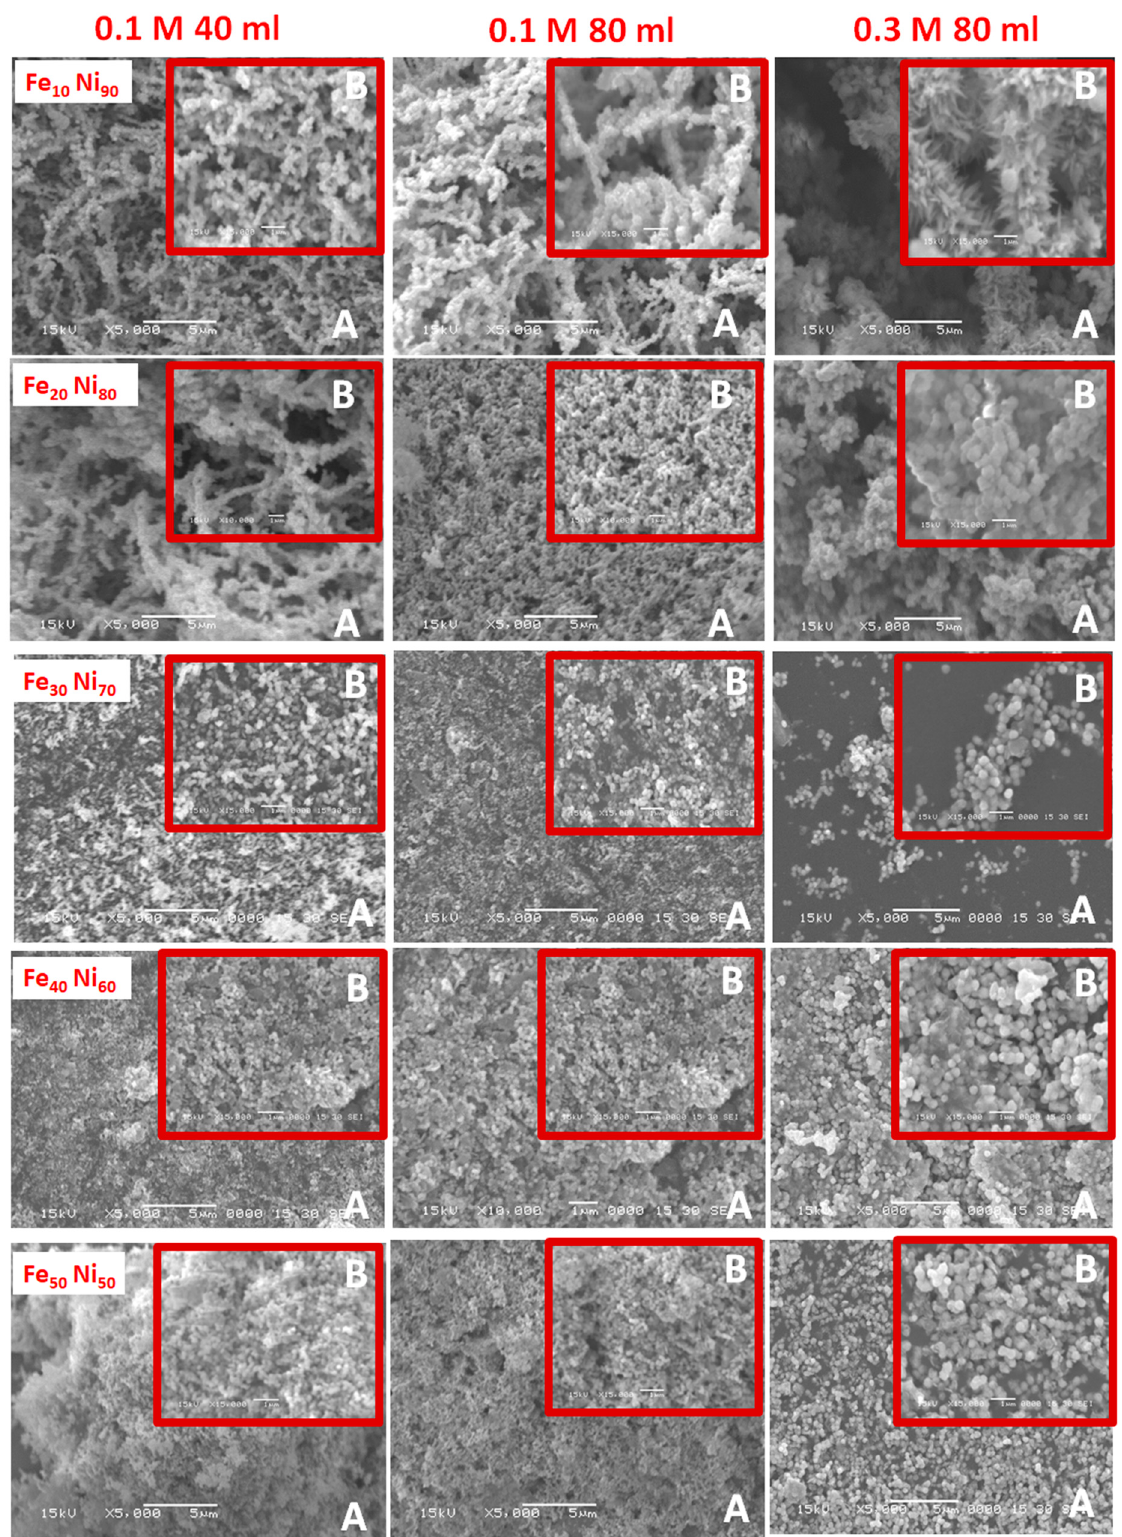
Figure 2. SEM images of the prepared iron-nickel alloy at two magnifications; ( A ) ×5000 and ( B ) ×15,000.